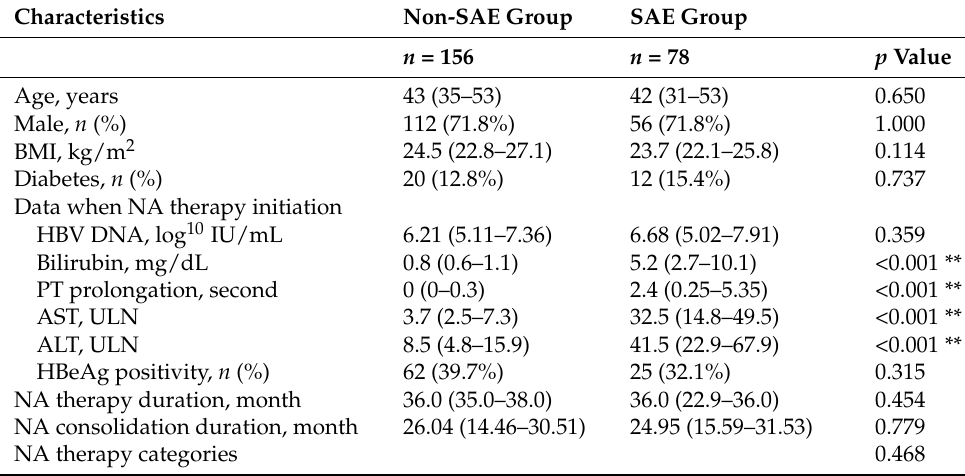
Table 1. Baseline characteristics of study